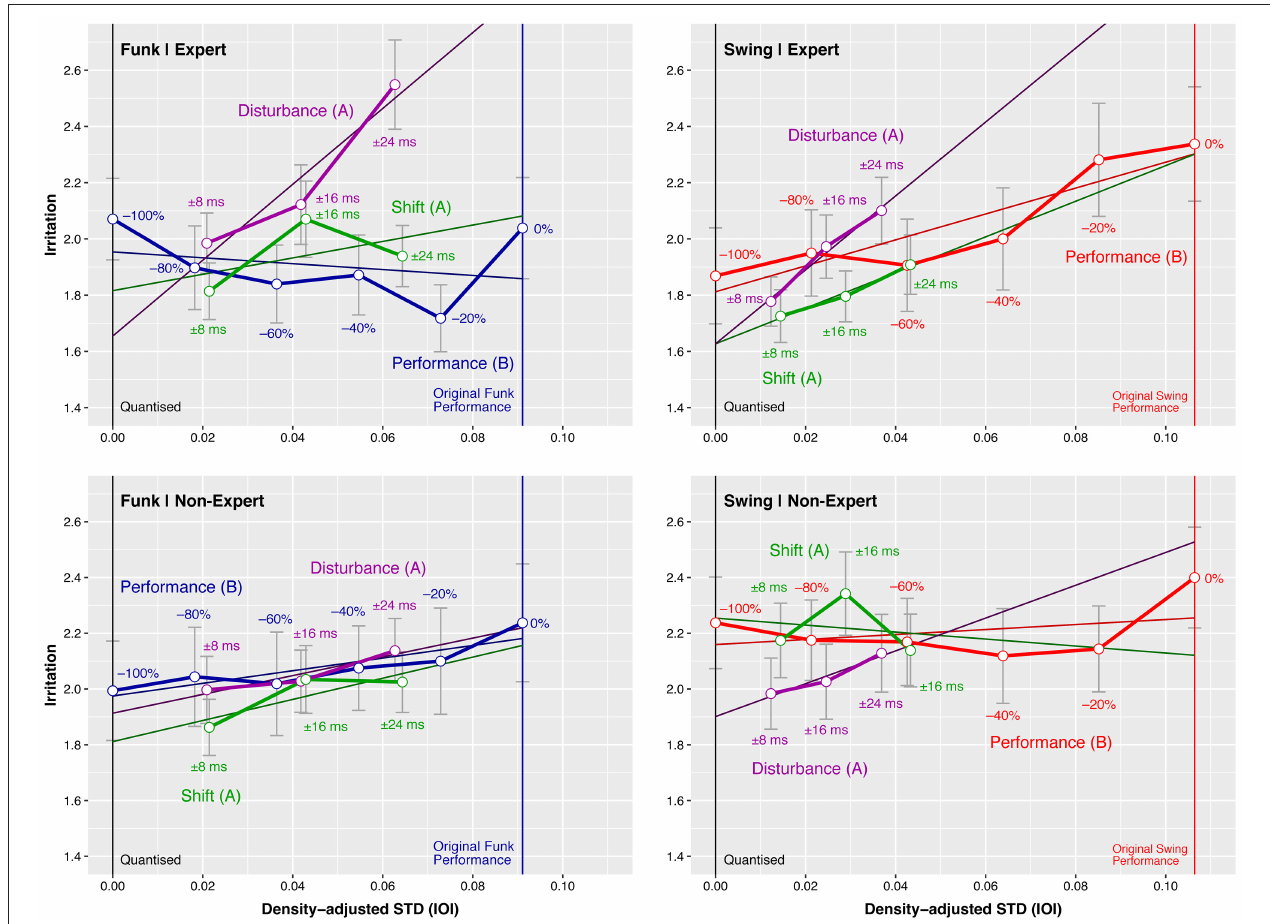
FIGURE 5 | Study C : Mean Irritation as a function of the Density-adjusted Standard Timing Deviation (proportion of mean IOI) across different Style / Expertise combinations for the Disturbance (purple) and Shift (green) manipulation patterns and the Performance pattern (blue or red) scaled from quantized to original magnitude. Error bars represent the standard error of the